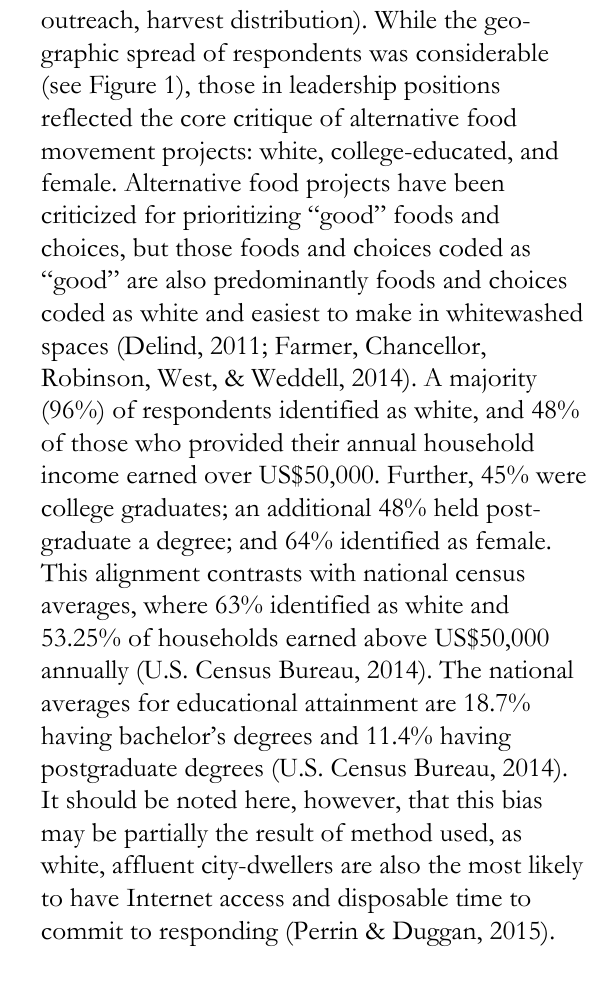
Figure 1. Map of Orchards Surveyed Nationwide. Larger dots indicate higher concentrations of